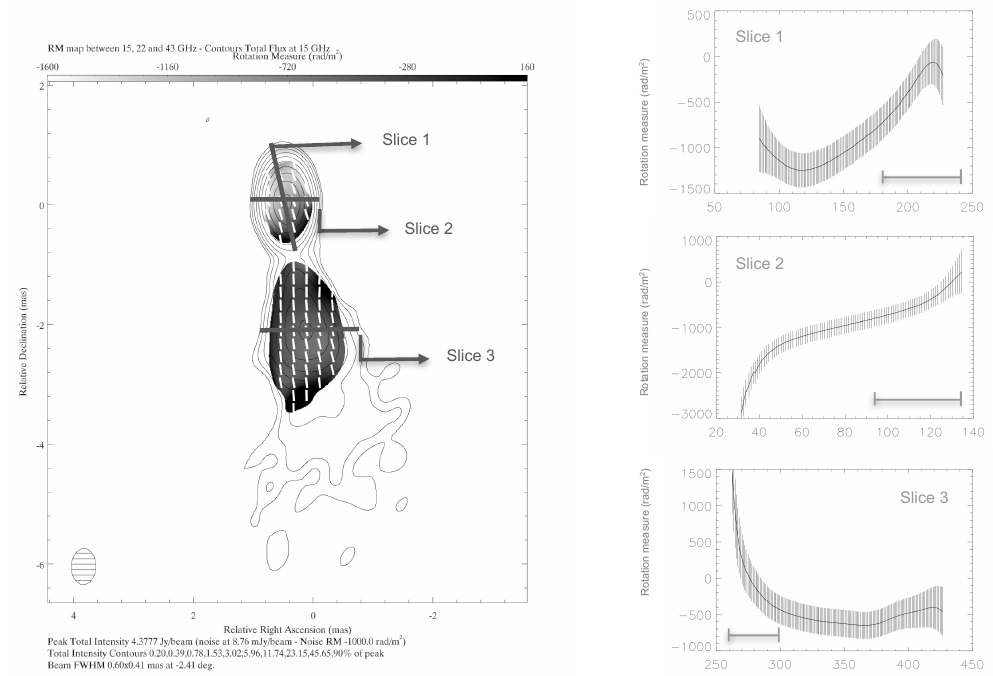
Figure 4. Rotation measure (RM) map, obtained by combining images at 15-22-43 GHz, and transverse RM slices of BL Lacertae. Contours show the 15 GHz image, grey scale indicates the rotation measure, and bars plot the electric vector position angles